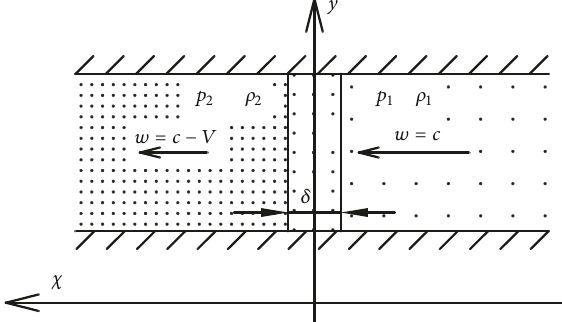
Figure 2: Transformed compressing wave model in the new coor-